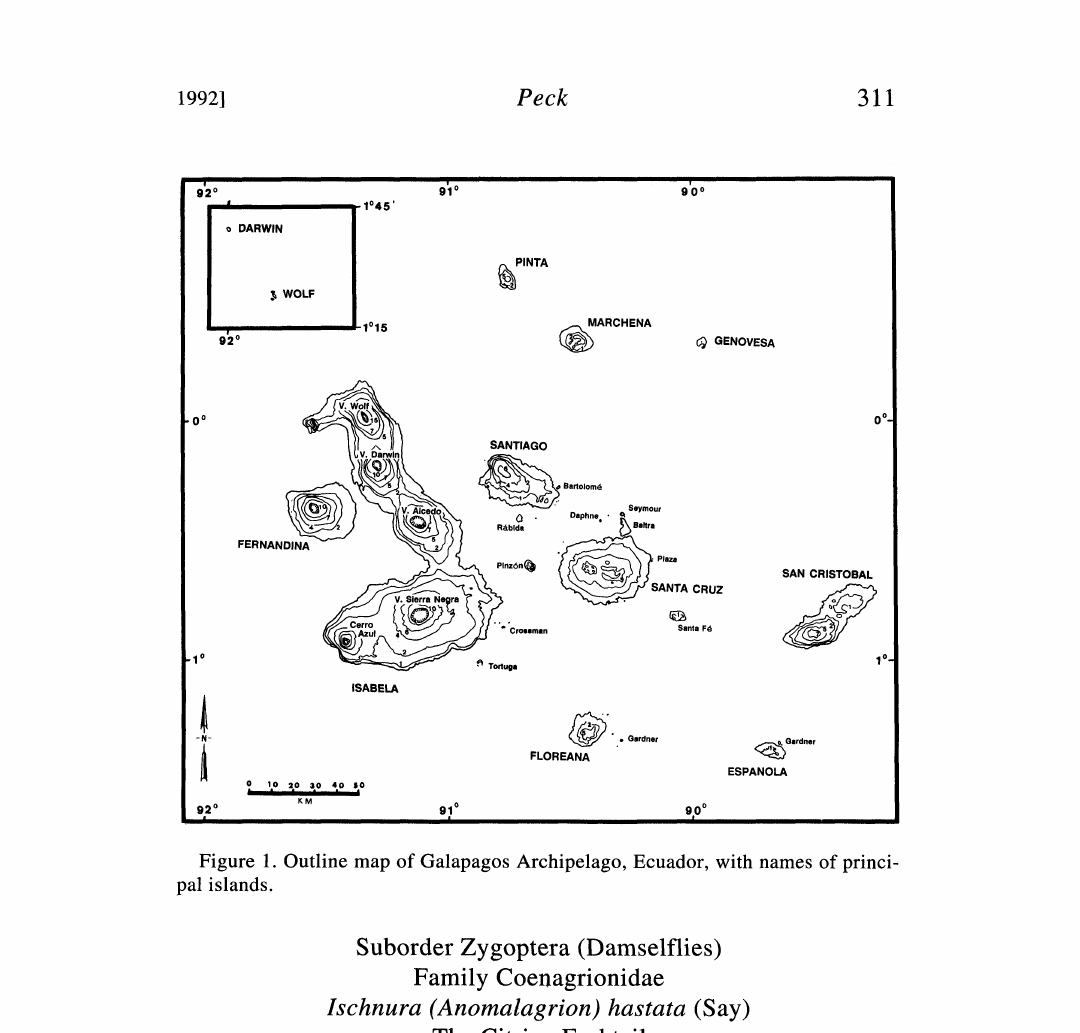
Figure 1. Outline map of Galapagos Archipelago, Ecuador, with names of princi- pal islands. Suborder Zygoptera (Damselflies) Family Coenagrionidae Ischnura (Anomalagrion) hastata (Say) The Citrine